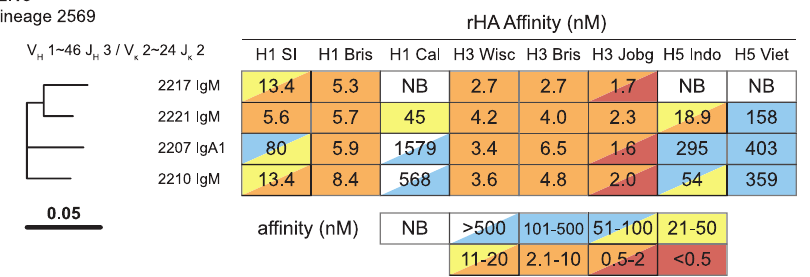
Figure 3. Clonal lineage 2569 from EI13. Three of 4 members (75%) derived from IgM-expressing plasma cells, 1/4 (25%) derived from an IgA1 plasma cell. The highest affinity binding for all members was to H3 Jobg; high affinity binding to other H3 rHAs and H1 Bris was also observed. Three members were tested for HAI and neutralization and displayed similar breadth (Table 3). H1 SI=H1N1 A/Solomon Islands/03/2006; H1 Bris=H1N1 A/ Brisbane/59/2007; H1 Cal=H1N1 A/California/04/2009; H3 Wisc=H3N2 A/Wisconsin/67/2005; H3 Bris=H3N2 A/Brisbane/10/2007; H3 Jobg=H3N2 A/ Johannesburg/33/1994; H5 Indo=H5N1 A/Indonesia/05/2005; H5 Viet=H5N1 A/Vietnam/1203/2004.